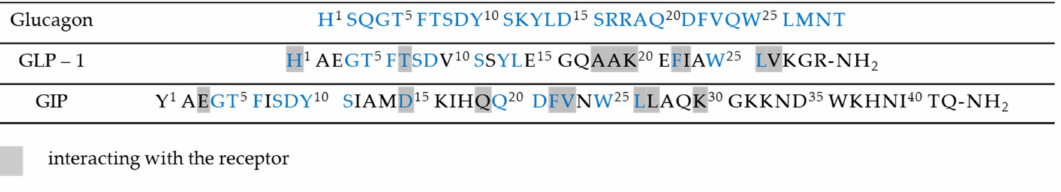
Figure 4. Amino acid sequences of glucagon-like peptide 1 (GLP-1), glucagon, and of glucose-dependent insulinotropic polypeptide